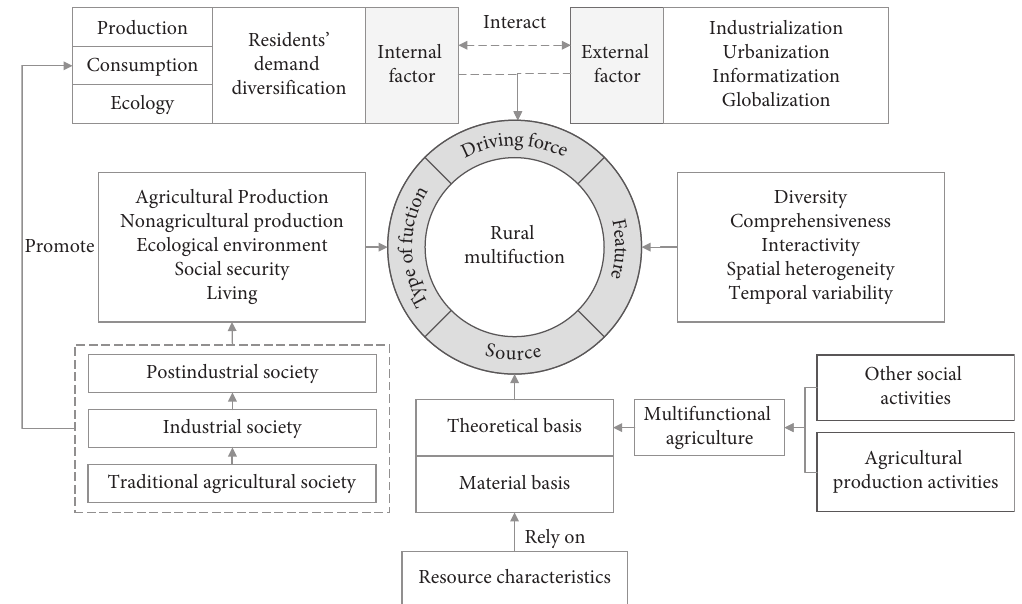
Figure 1: Scientific cognition of rural